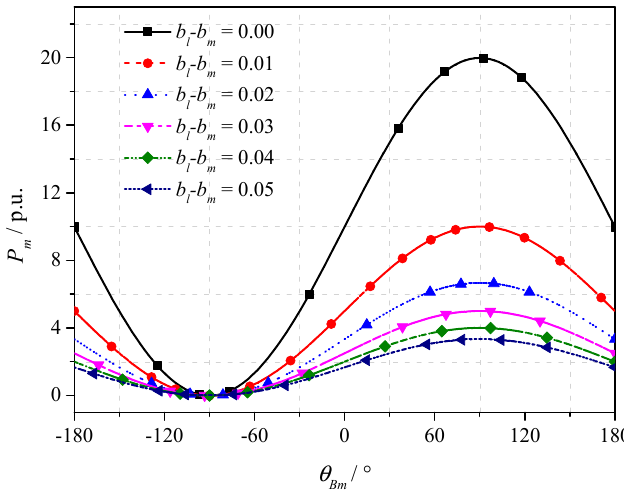
Figure 9. θ Bm - P m curve under different b l - b m .